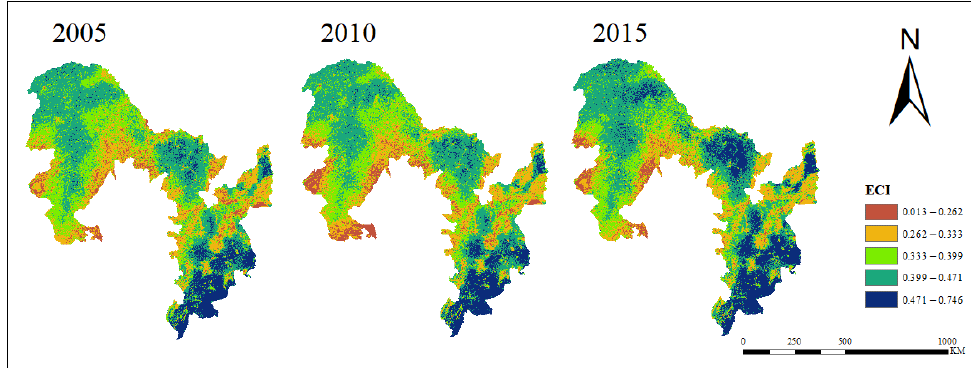
Figure 10. Spatial distribution of different levels of the comprehensive index in the NFB from 2005–2015. Table 9. Statistics of different levels of comprehensive index data of the NFB from 2005–2015.